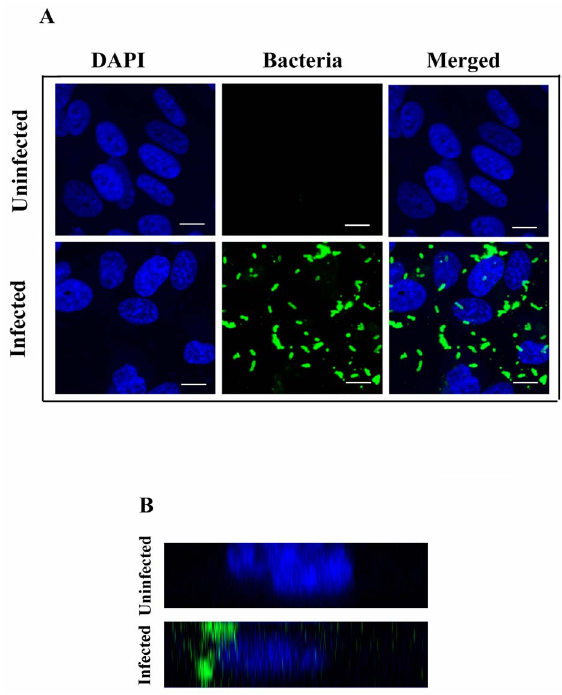
Figure 2. Confocal Microscopy of HMEECs infected with P. aeruginosa . HMEECs were infected with P. aeruginosa at an MOI of 10 for 2h and then bacteria were stained with anti- P. aeruginosa antibody followed by a secondary Alexa Fluor H 488 antibody. The slides were counterstained with 4’,6-diamidino-2-phenylindole (DAPI) and visual- ized by confocal laser fluorescence microscope (A). The analytical sectioning was performed from top to bottom of cells and orthogonal panels were prepared demonstrating bacterial invasion of HMEECs (B). Results are representative of four independent experiments carried out in triplicate. Scale bars 10 m